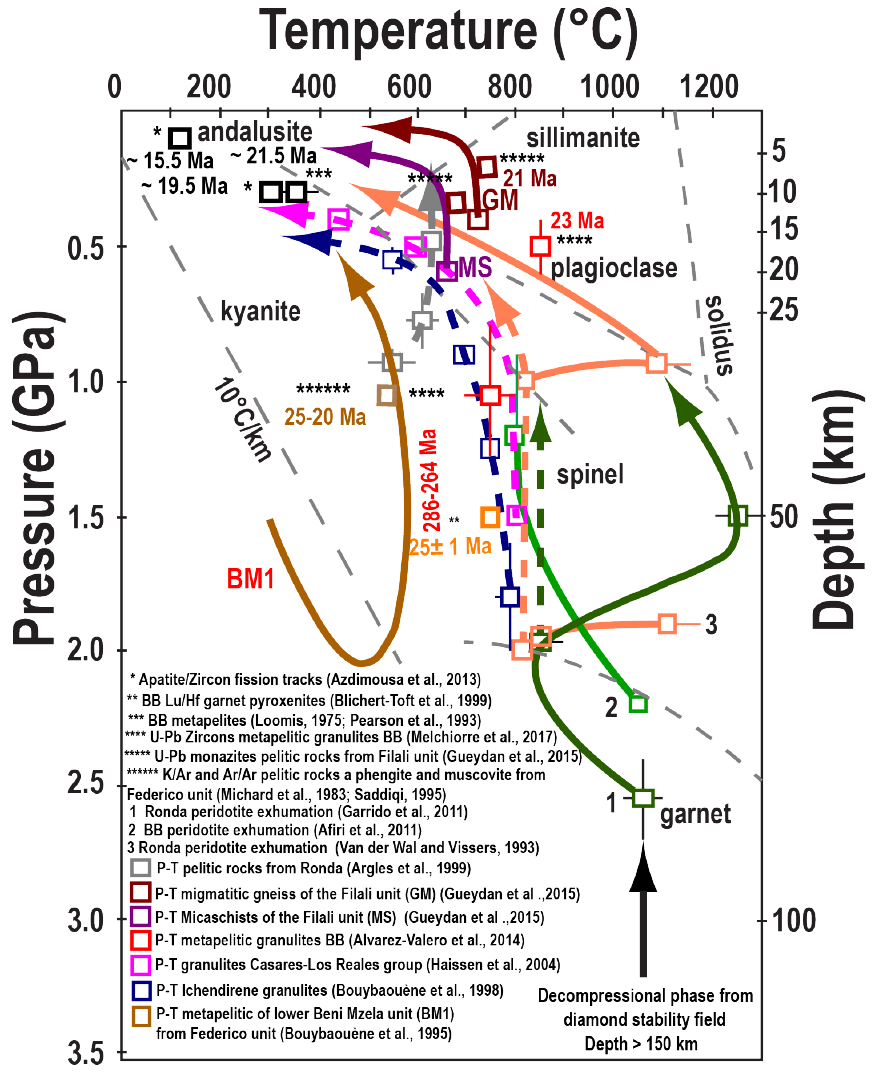
Figure 12. Summary diagram of the different pressure–temperature–time (P-T-t) paths, as well as geochronological data, of peridotite emplacement, tectonometamorphic events of the entire Alboran domain units in Beni Bousera (BB), and Ronda, modified from Melchiorre et al.